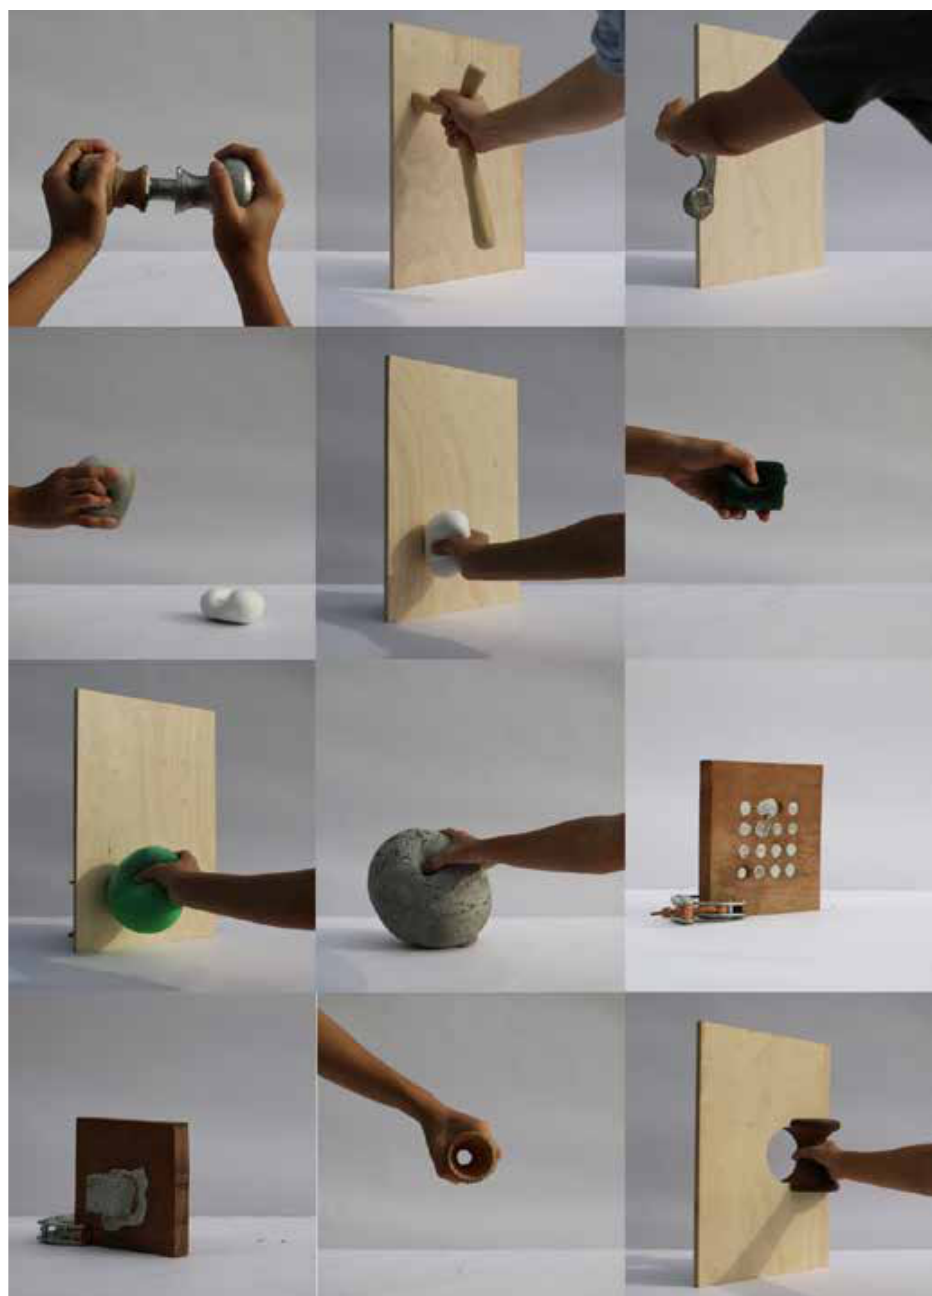
Figure 3: Making sketches that we can touch. Investigations into the use of metals as a conductor, which pre-emptively inform a user of interior conditions. These works use both intuitive forms, and found objects which break from known conventions. As fragments of thresholds, these objects explore engagement of door edges and the penetration of the door surface. Source: